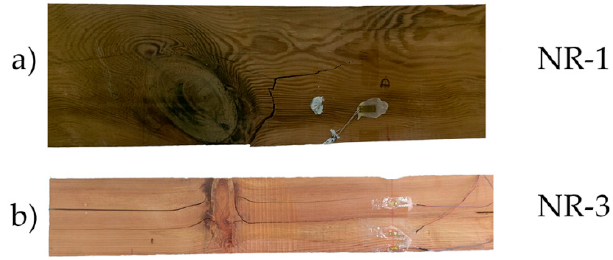
Figure 6. Breakage patterns of the NR beams group: ( a ) NR-1; and ( b ) NR-3.